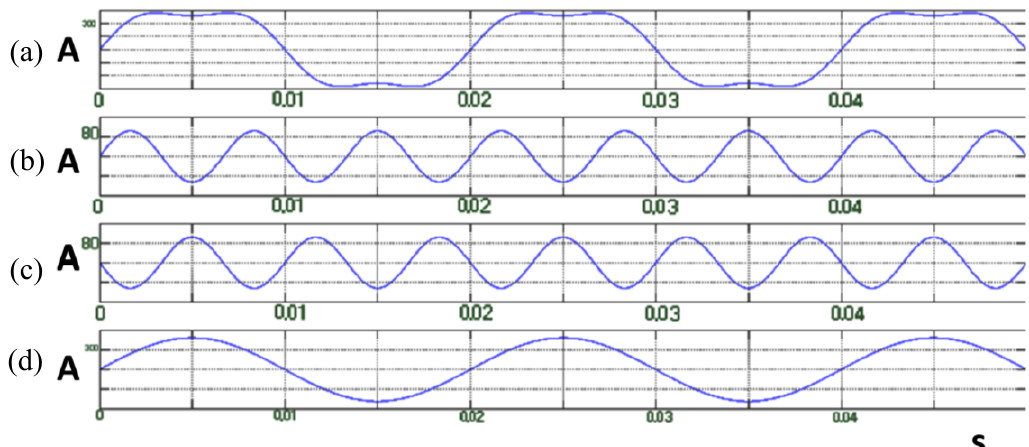
Figure 3. ( a ) Distorted ac grid’s current before compensation; ( b ) 3rd harmonic component at the grid before compensation; ( c ) Mirror 3rd harmonic component injected to the PCC; ( d ) AC current of the grid after harmonic compensation.